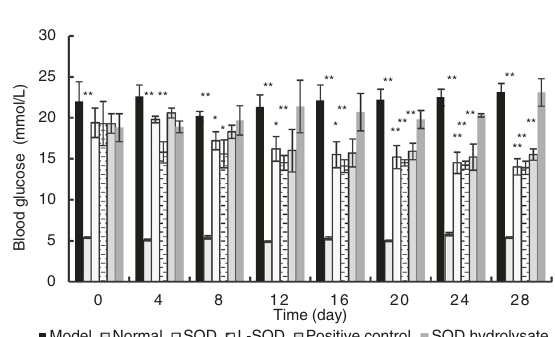
Fig. 2 GSSG/GSH in the colons of T2D model rats after 4-week intervention. The data are presented as mean ± SD, n = 6 each group. * P < 0.05, ** P < 0.01 vs. model group.